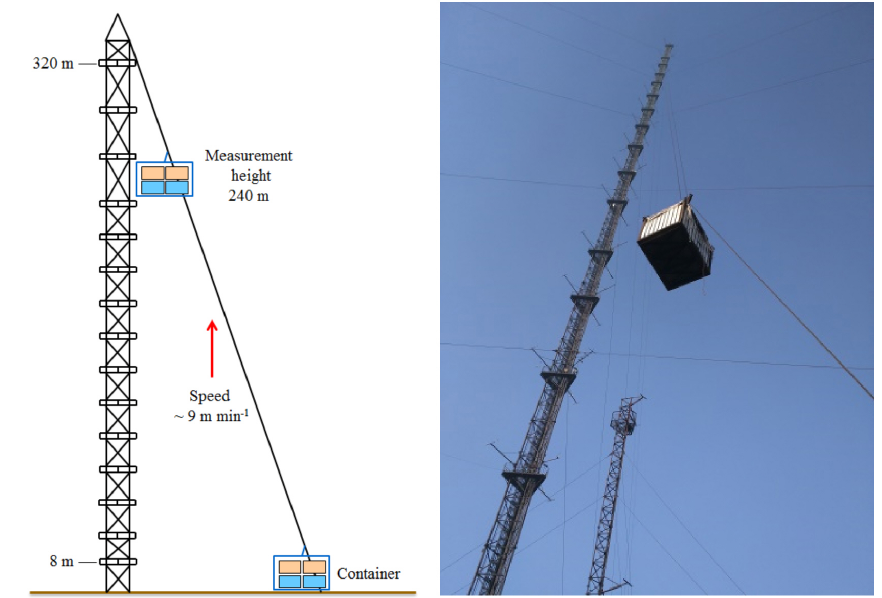
Figure 1. The Beijing 325m meteorological tower (BMT) at the Institute of Atmospheric Physics (IAP).